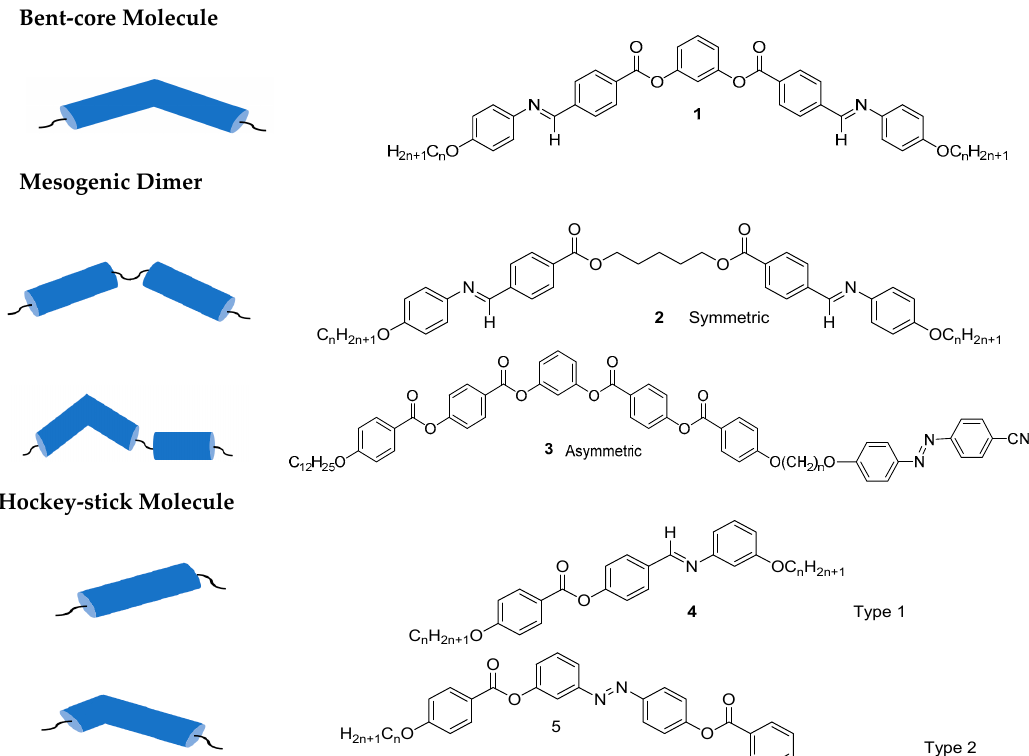
Figure 1. Schematic representation of three types of bent-core liquid crystals and their chemical structures [67–69].